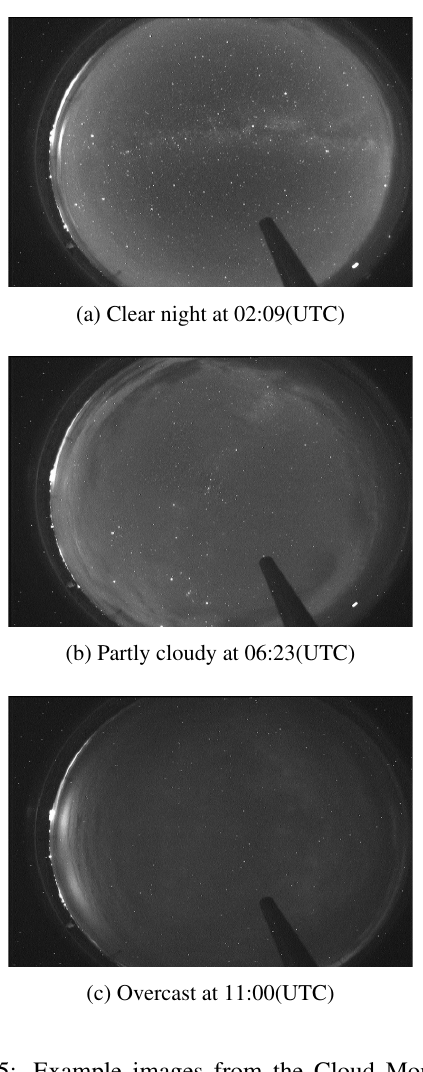
Figure 5: Example images from the Cloud Monitoring System from the taken on 20 Nov. 2014. Central Laser Facility. coordinate of Fig. 6a. Black sold circles are SAO star